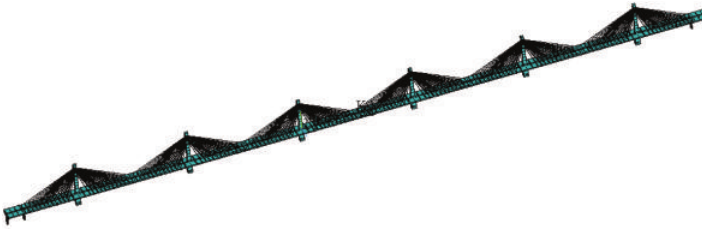
Figure 2: Finite element model of Jiashao Bridge.